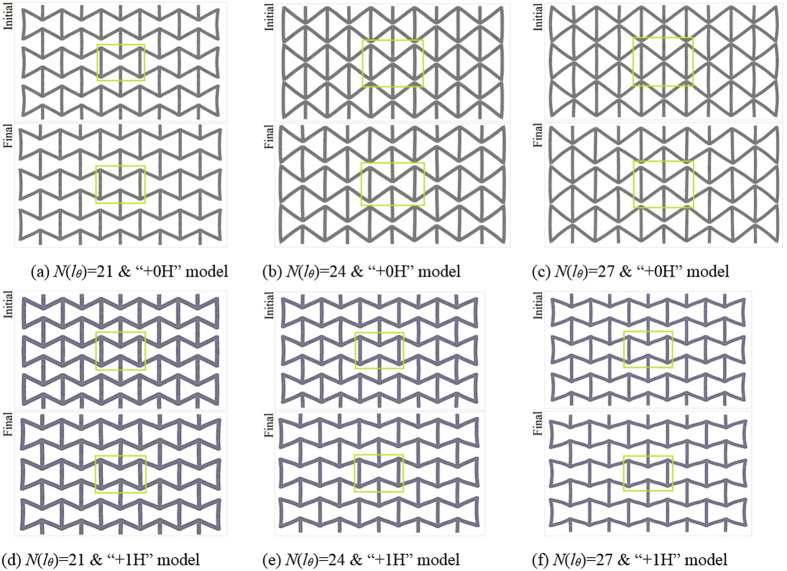
Comparison of configurations before and after deformation with respective to different lengths of oblique bar.In each inserted figure, the mid microstructure is labelled with a solid lime frame. In each case, the configuration of the structure is formed with three layers of microstructures. The upper figure in each case is the initial configuration after relaxation, the lower figure in each case is the final stable configuration after loading and relaxation.